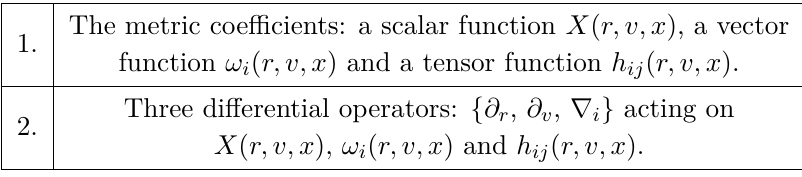
Table 1 . The basic building